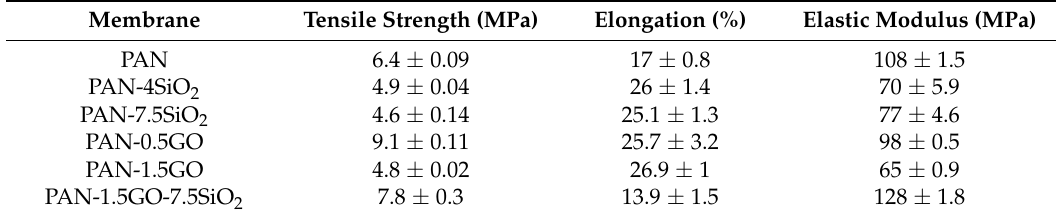
Table 4. Mechanical properties of developed membranes with different